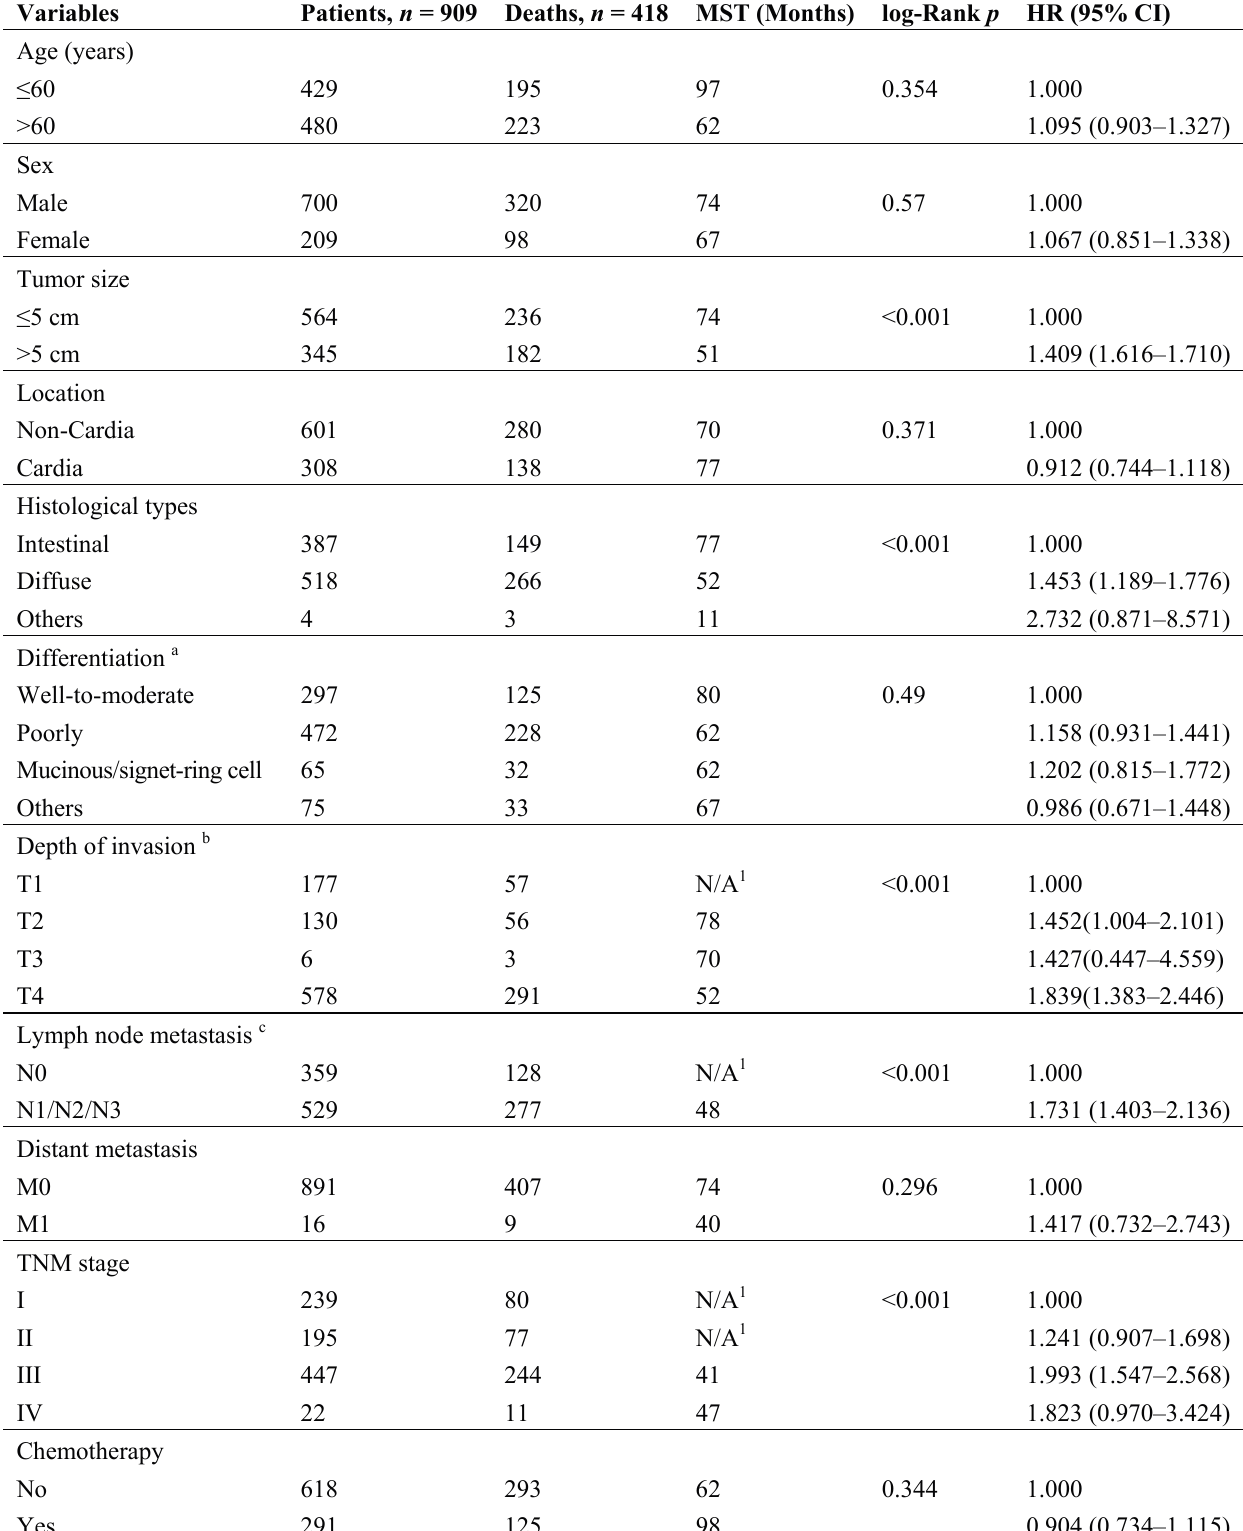
Table 1. Association between clinicopathological features and survival of gastric cancer.